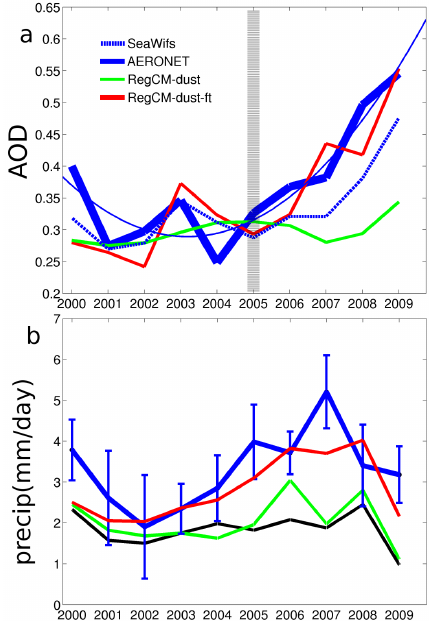
Figure 1. Arabian AODs and southern India deseasonalized precip- itation trends during the decade 2000–2009. (a) The thick blue line represents monthly deseasonalized time series of JJAS AODs ob- tained from the Solar Village AERONET station (monthly product, average of 480–640nm spectral bands). A quadratic regression fit, showing the progressive intensification of observed dust activity, is superimposed (blue curve). The blue hatched line represents the de- seasonalized AOD time series obtained from SeaWIFS AOD inter- polated on the Solar Village station. The green lines represent the monthly deseasonalized time series (as well as the corresponding quadratic fit) of JJAS AODs simulated by the model in dust simula- tion. The red lines represent the monthly deseasonalized time series (as well as the corresponding quadratic fit) of JJAS AODs simu- lated by the model with forced dust emission trends ( dust _ ft simu- lation). (b) The blue line represent the yearly time evolution of ob- served continental precipitation averaged for JJAS, over a southern India box (5–20 ◦ N, 60–80 ◦ E) and for different data sets (TRMM, CRU, PERSIANN). The blue bars materialize the amplitude be- tween maximum and minimum values amongst observations for a given year. The equivalent deseasonalized JJAS average simulated precipitations are reported for the nodust simulations (black line), the dust standard simulations (green line) and the forced emission trend dust _ ft simulations (red line). All modeling results represent a three-ensemble-member